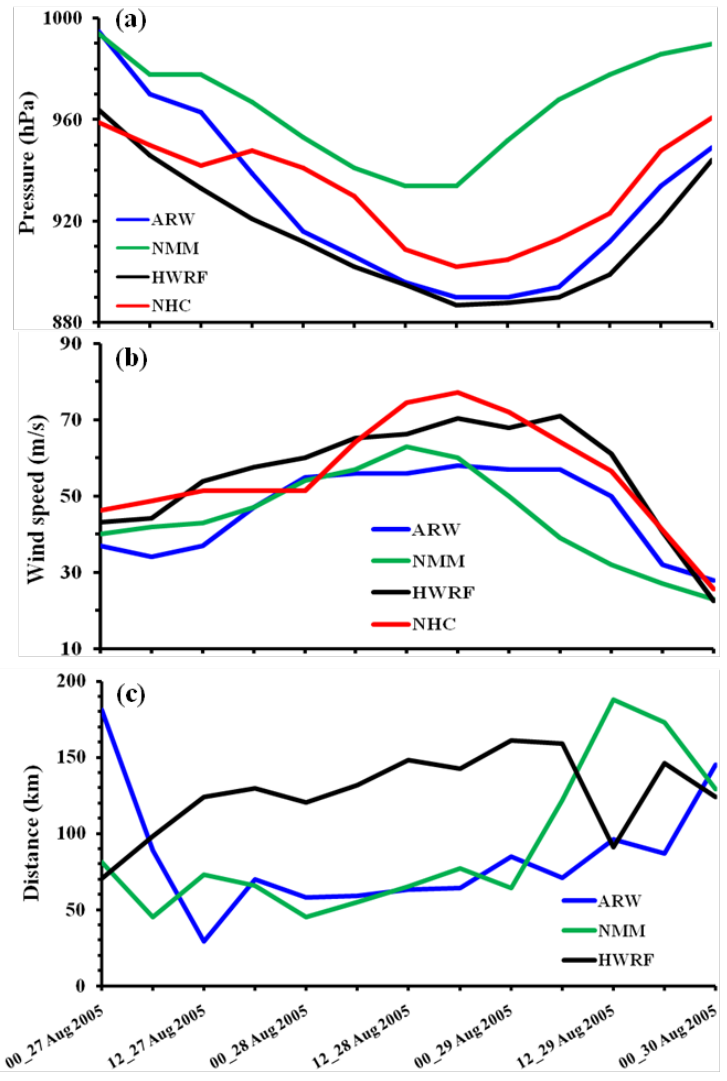
Figure 5 . Time series of model predicted (a) central sea level pressure (hPa) (b) maximum wind (m/s) and (c) radius of maximum wind (km) for the experiments with ARW, NMM and HWRF models. NHC estimates of CSLP and MW are noted along with model predicted time